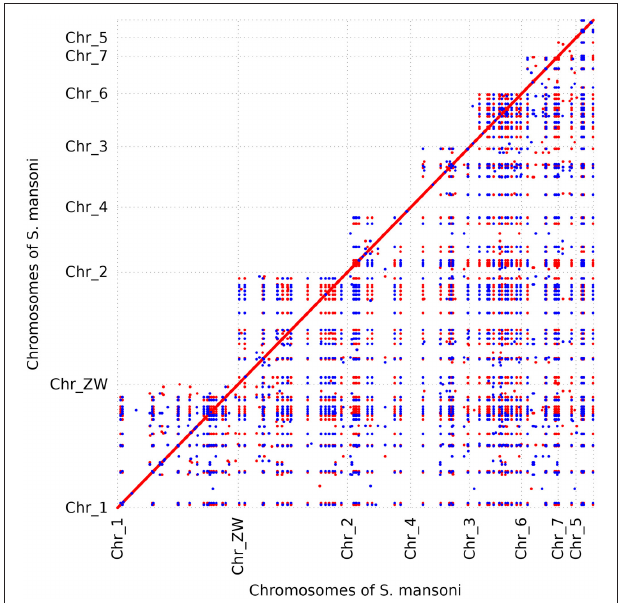
FIGURE 2 | Dot plot of recent segmental duplication blocks in S. mansoni genome. The blocks were determined by Nucmer. Orientation is diagrammed with different colors. Only the blocks ≥ 5 kb are shown. A high proportion of these sequences are retrotransposons that are widespread in the genome. The tandem dots suggest that the genome has experienced substantial small tandem duplications. Some genomic regions seem to be duplicated in all the